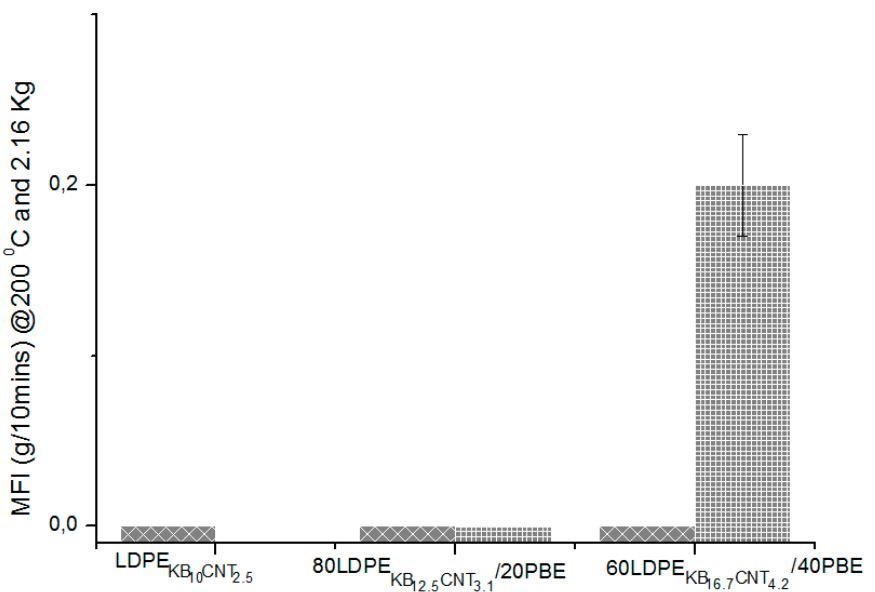
Figure 21. MFI (g / min @ 200 ◦ C / 2.16 kg) of the conducting biphasic blends using 1-step ( Figure 25. Strain (%) of the conducting biphasic blends produced by a 1-step ( ) or 2-step Figure 25. Strain (%) of the conducting biphasic blends produced by a 1-step ( ) or 2-step Figure 21. MFI (g/min @ 200 °C/2.16 kg) of the conducting biphasic blends using 1-step ( ) or 2- 2-step ( ( ) extrusion 3D-printed onto textile materials in the cross ( a ) and machine ( b ) directions of the ( ) extrusion 3D-printed onto textile materials in the cross ( a ) and machine ( b ) directions of the step ( ) extrusion. fabric. fabric.